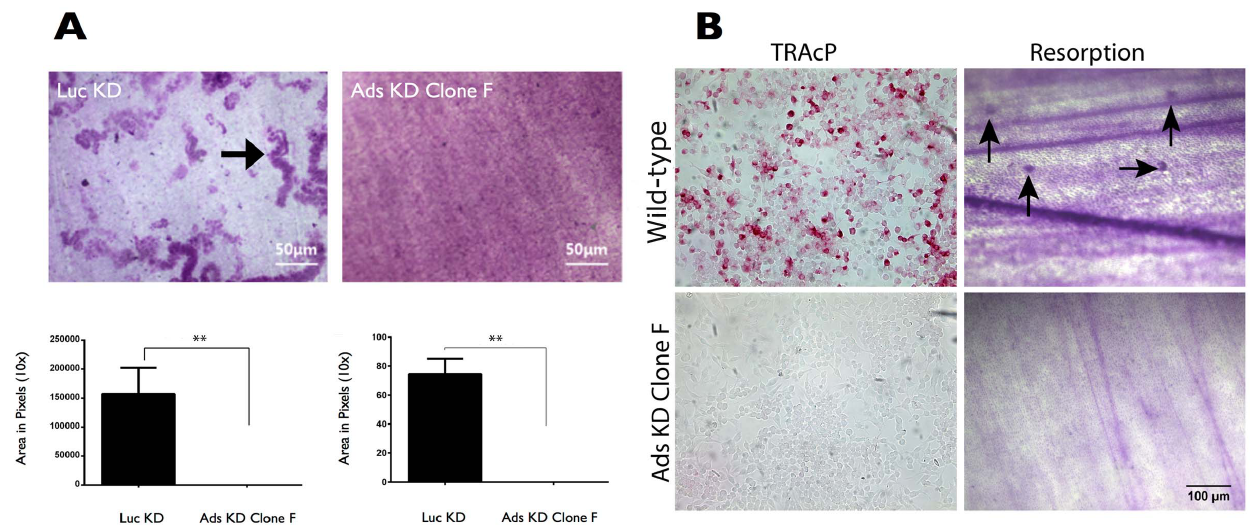
Figure 8. Adseverin knockdown osteoclasts fail to resorb mineralized matrix. A ) Luc KD and Ads KD osteoclast precursors were cultured on dentin discs for 4 days. Mature Luc KD osteoclasts were capable of resorbing the dentin disc substrate (black arrow) significantly better than Ads KD cells, as indicated by the total resorbed area. Ads KD Clone F cultures had virtually no multinucleated osteoclasts or detectable resorption pits. B ) WT and Ads KD (Clone F) cells were cultured for 2 days with sRANKL. More than 80% of WT cells were TRAcP. WT mononuclear TRAcP positive osteoclasts were capable of minimally resorbing the dentin slices as indicated by the small resorption pits (black arrows). Immature, Day 2 Ads KD cultures were TRAcP negative and displayed no resorptive ability.